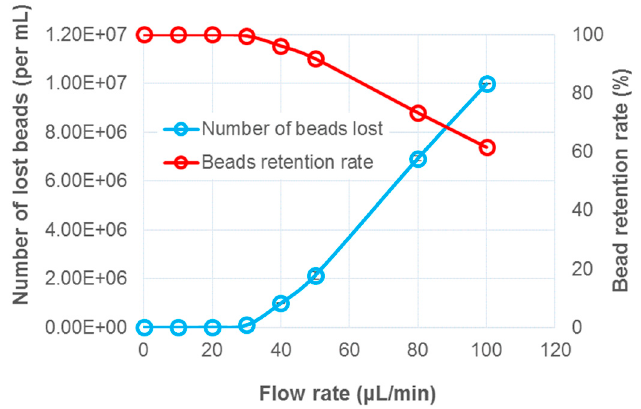
Figure 4. Limits of immobilizing magnetic beads using a magnet under the flow. Beads start to be flushed away with increased flow rate. ~100% bead retention rate achieved at 10 μ L/min.